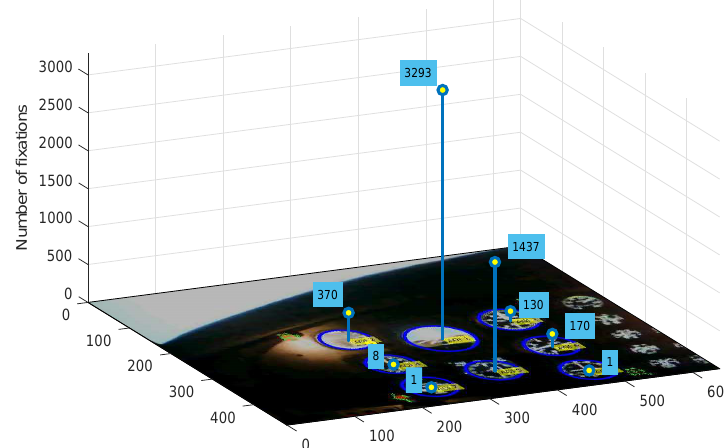
Figure 7. The number of fixations formed on the basis of AOI analysis by Tobii Pro Studio software with individual analysis of particular